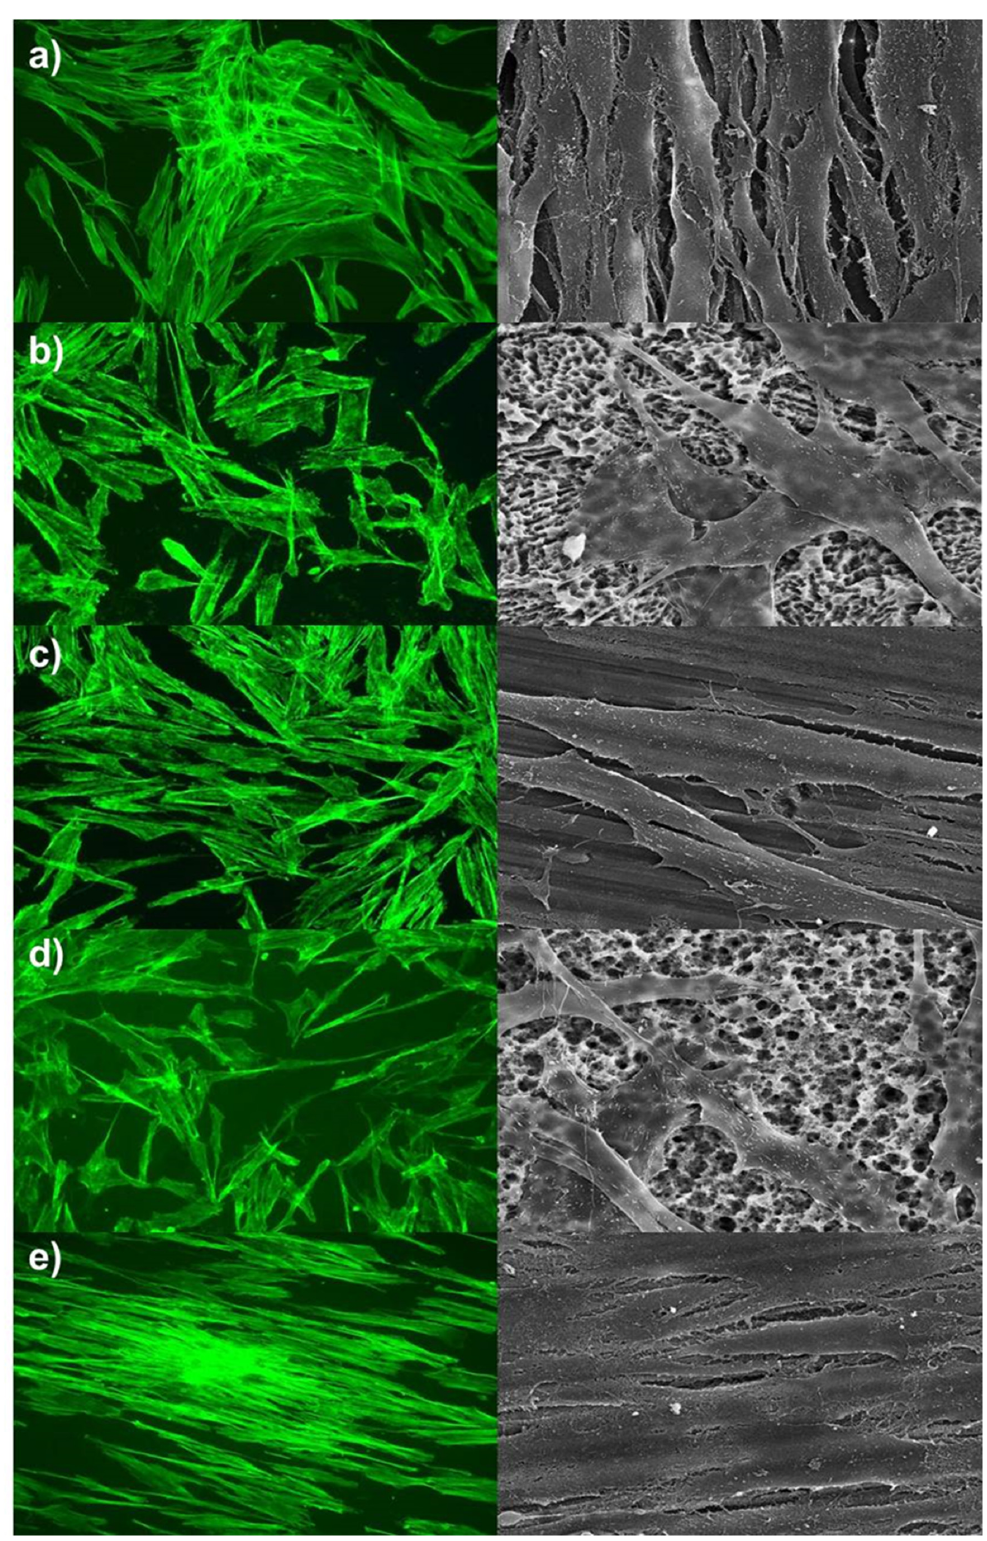
Figure 3. Alterations in the cell morphology of human gingival fibroblasts cells (HGFs). (Left site = f-actin staining, magnification factor ×100; right site = SEM, magnification factor ×1200. ( a ) Control, ( b ) Titan-SLA, ( c ) Titan-PT, ( d ) ZrO 2 -ZLA, ( e ) ZrO 2